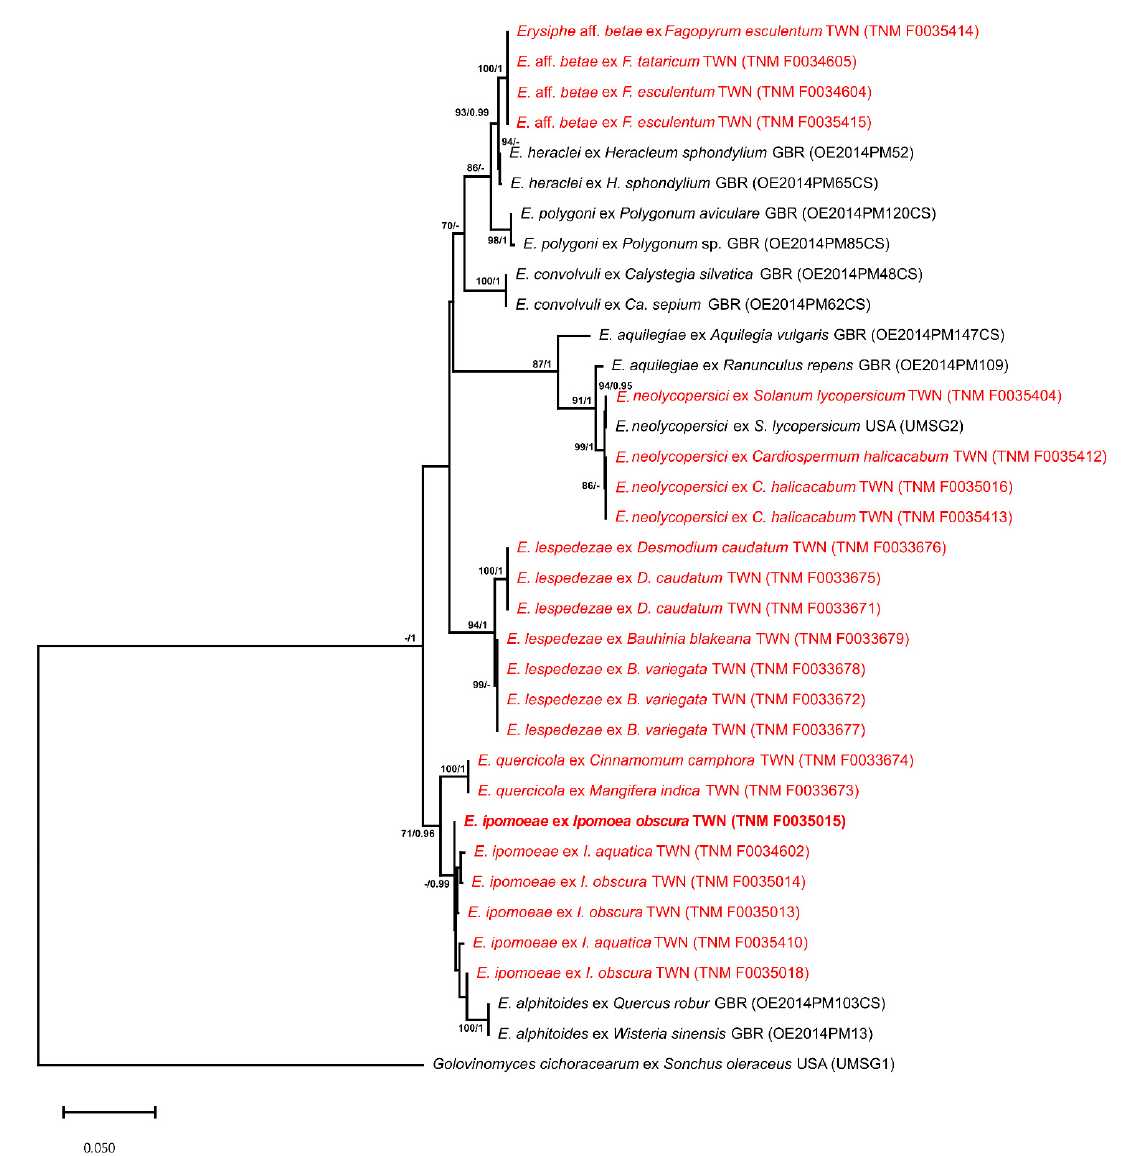
Figure 2. RAxML tree based on the concatenated sequences of ITS and TUB2 from Erysiphe . G. cichoracearum is used as an outgroup taxon. Maximum likelihood bootstrap values ≥ 70% and Bayesian posterior probabilities ≥ 0.95 are given at the nodes. Sequences obtained in this study are shown in red. Ex-type sequences are indicated in bold.